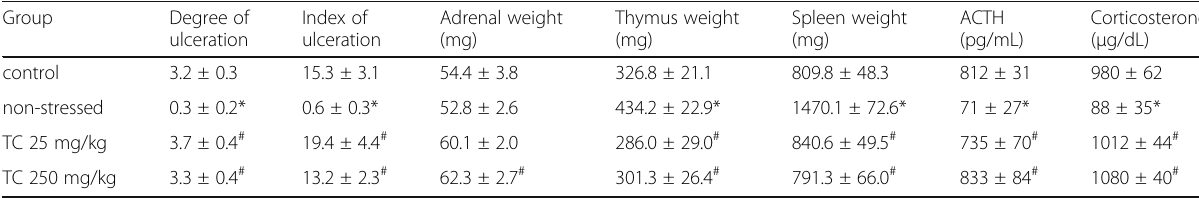
(*) p <0.05: statistically different of control (stressed) group; (#) p <0.05: statistically different of non-stressed group. ANOVA followed by Duncan